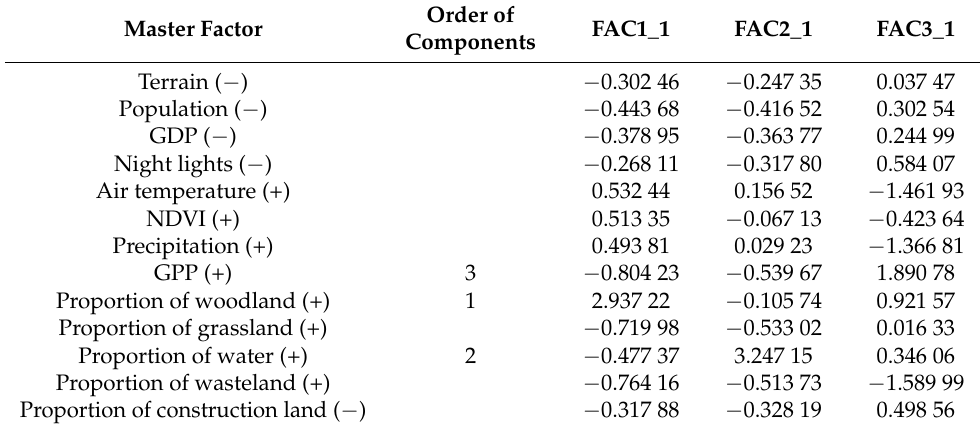
Table 7. Main control factors in 2015.